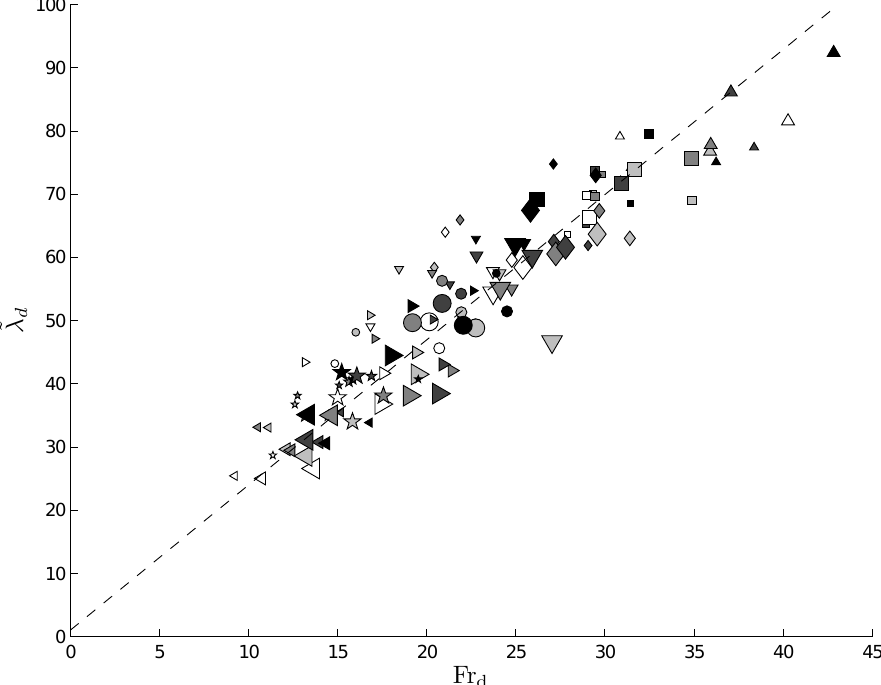
suggesting that the dominant instability mechanism is now more similar to those observed in unsuspended granular flows. Particle diameter of the granular material has been found to play a central role in determining the wavelength of the lobe and cleft pattern, as hypothesised by Nohguchi and Ozawa (2008). When scaled with particle diameter, a relationship between the Froude number of the flow and wavelength of the lobe and cleft pattern has been found. This relationship highlights the importance of the role played by drag forces acting on the individual particles in determining the wavelength of the frontal pattern, and appears to support the concept of a velocity boundary layer at the moving front of the